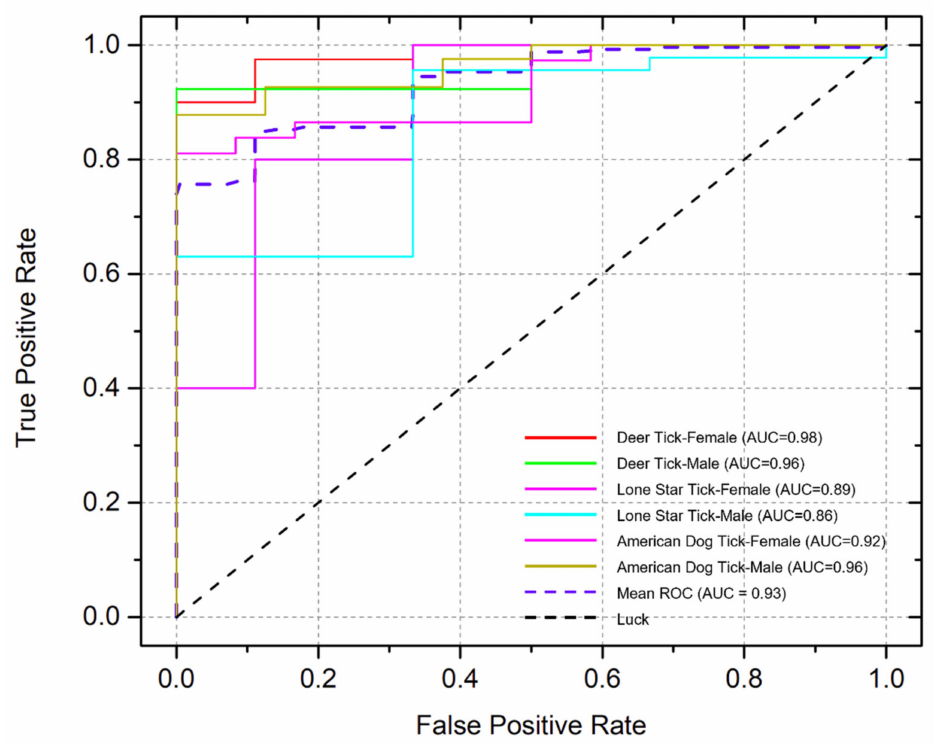
Figure 7. Receiver-operating characteristic curve analysis of identification of three common tick species, including female deer ticks, male deer ticks, female lone star ticks, male lone star ticks, female American dog ticks, and male American dog